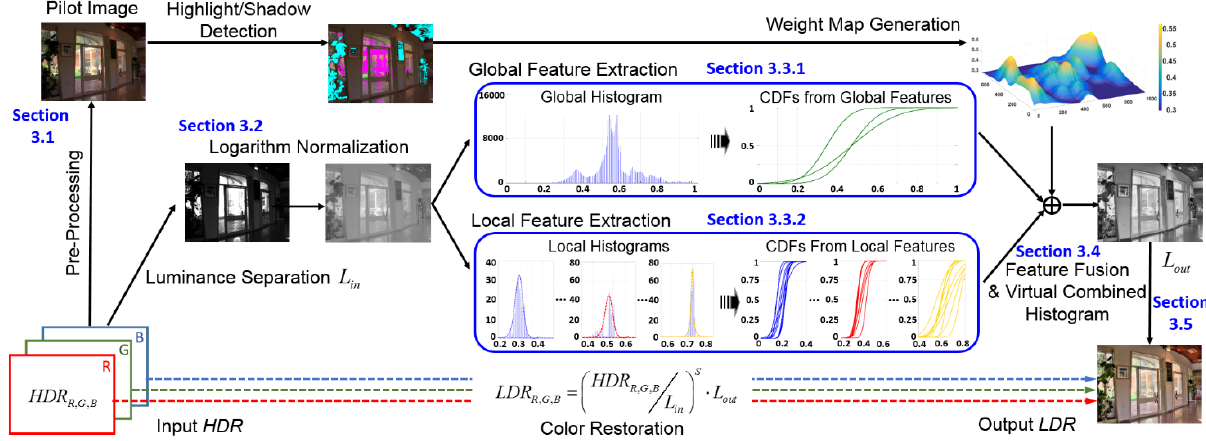
Figure 2. Flowchart of the proposed method, where the blue bold words indicate the section numbers.